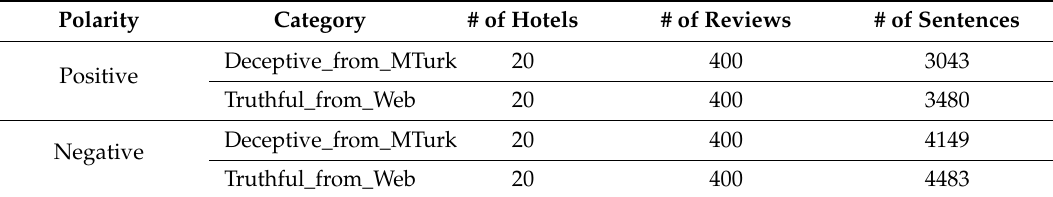
Table 5. The basic information about reviews in the spam dataset.